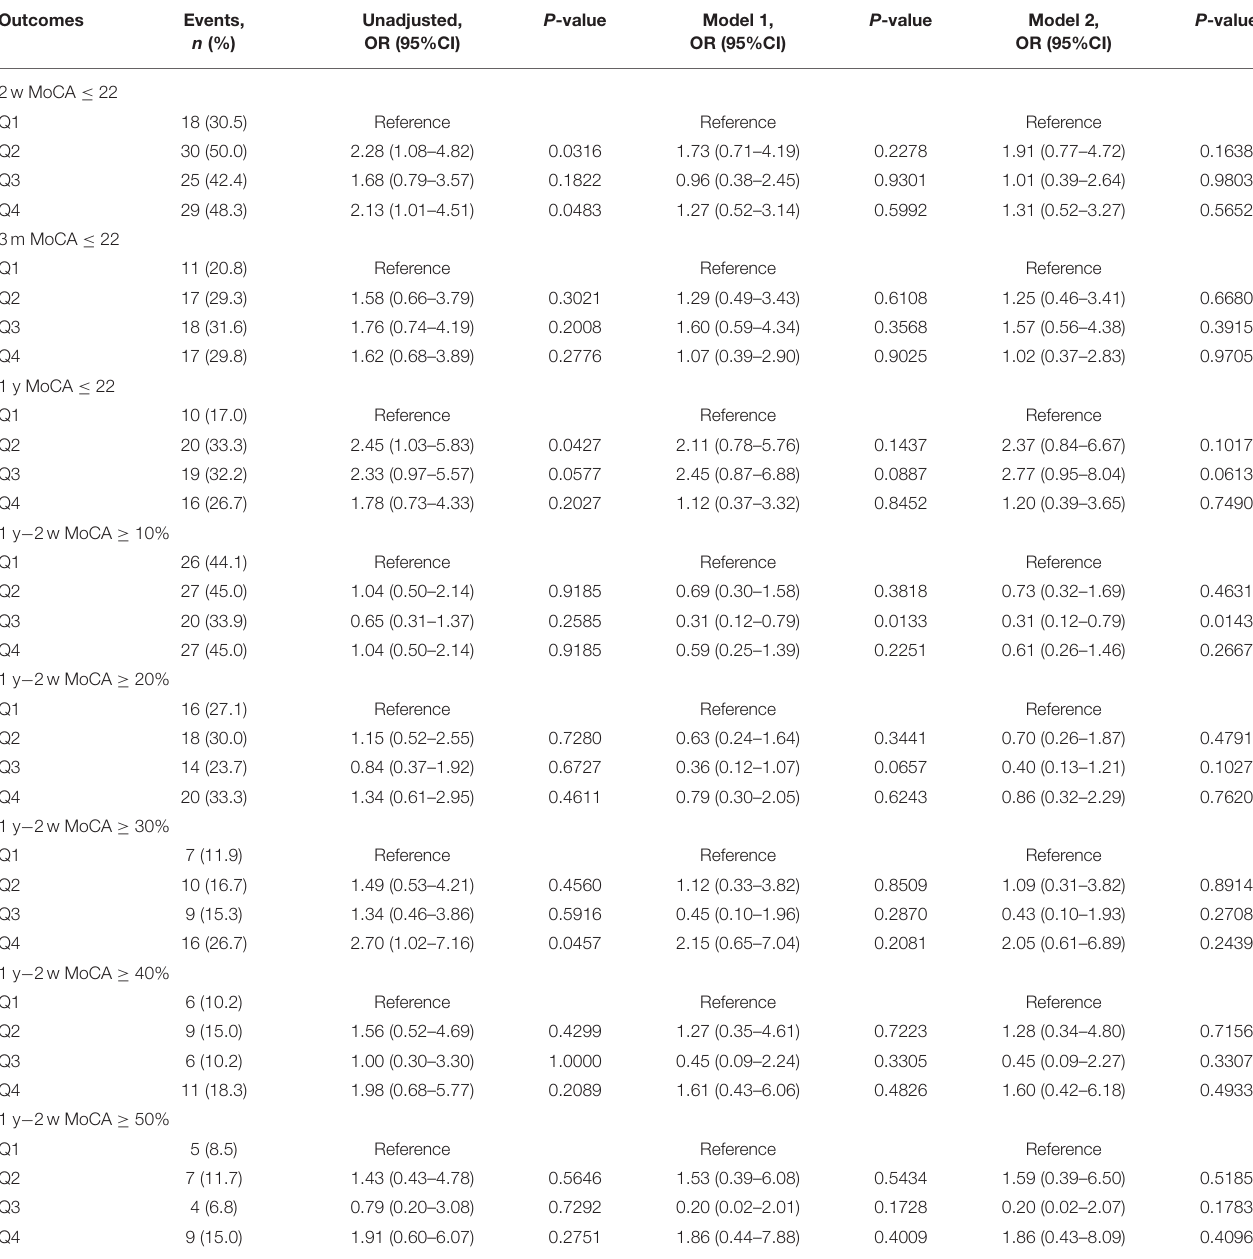
TABLE 4 | Subgroup analysis in patients with small-vessel occlusion (SAO) subtype.